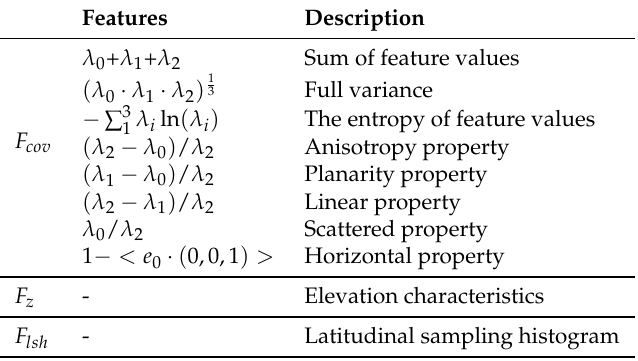
Table 2. The selected features for the initial coarse labeling of fine-grained clusters. Symbol “-” represents the specific descriptor that needs to be defined in each application.